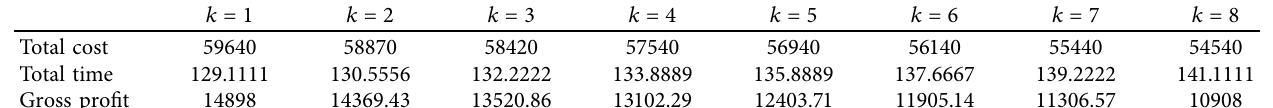
Table 7: Calculation results of total cost, total time, and gross profit.